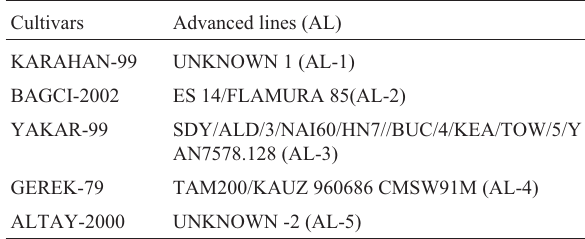
Table 1 - Bread wheat genotypes tested in 19